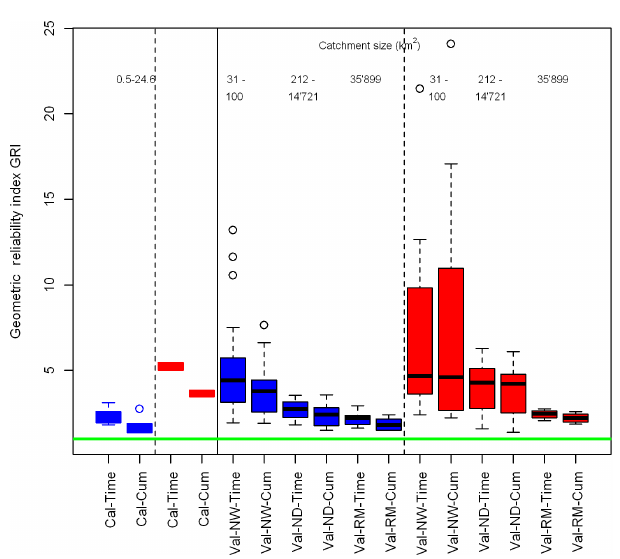
considerably poorer but the cumulative distribution was also reproduced better that the concentration time